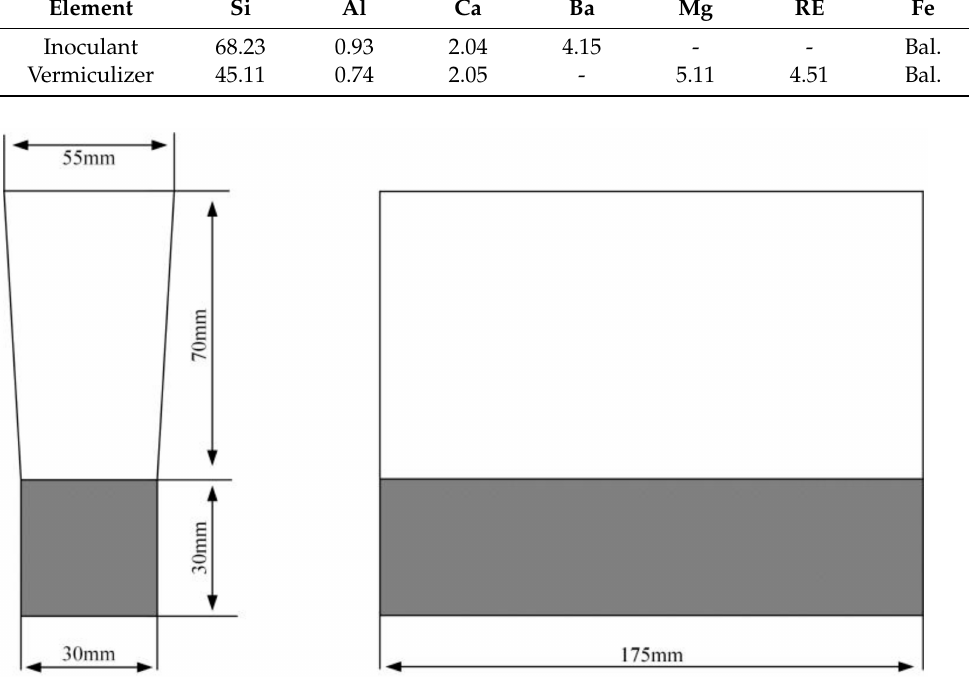
Figure 1. The schematic diagram of wedge-shaped pouring samples of CGI. Table 2. Chemical composition of original and investigated CGI samples